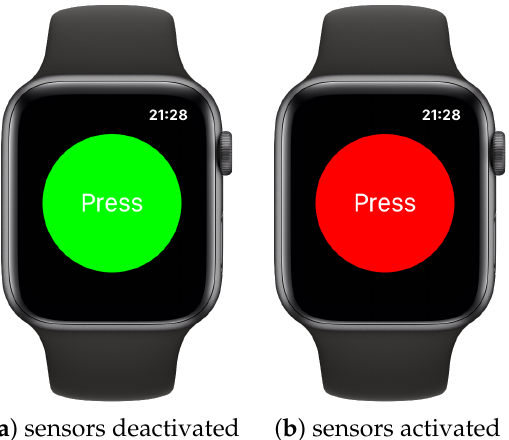
Figure 2. User interface of the smartwatch. A simple button as an activation method. When the button is pressed the color changes to red and the sensors begin to transmit data until it is pressed again.